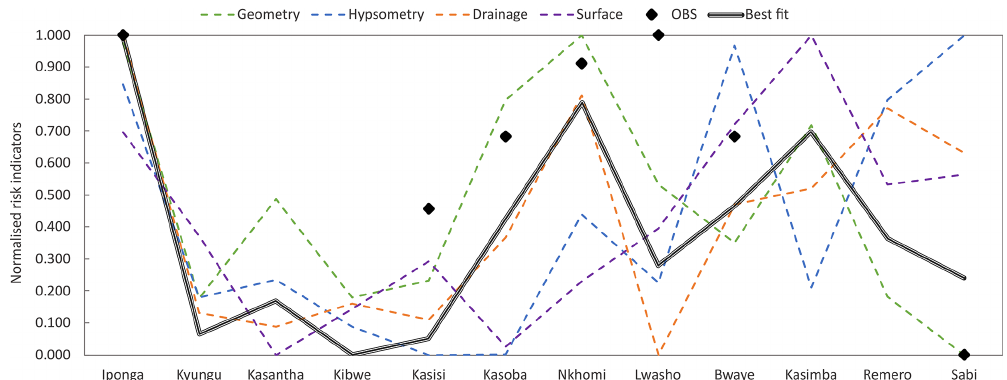
Figure 4. Results from the PCA of the four catchment characteristic categories and weighted flash flood catchment susceptibility. The black dots correspond to the normalised estimation of the flash flood frequency of the communities visited (OBS: observed). Catchments are ordered from north to south (left to right).